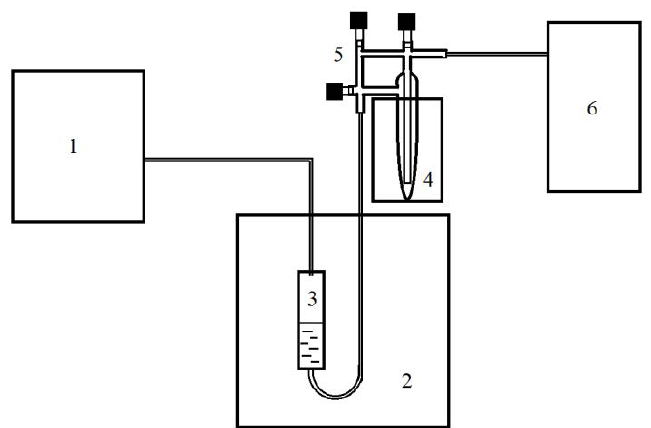
1—chromatograph; 2—thermostat; 3—reactor with catalyst; 4—thermostat; 5—ampoule bubbler with Figure 4. Scheme of an experimental setup for studying the kinetic characteristics of the catalyst: SiHCl 3 (SiH 2 Cl 2 ); 6—flow 1 — chromatograph; 2 — thermostat; 3 — reactor with catalyst; 4 — thermostat; 5 — ampoule bubbler with SiHCl 3 (SiH 2 Cl 2 ); 6 — flow stabilizer.